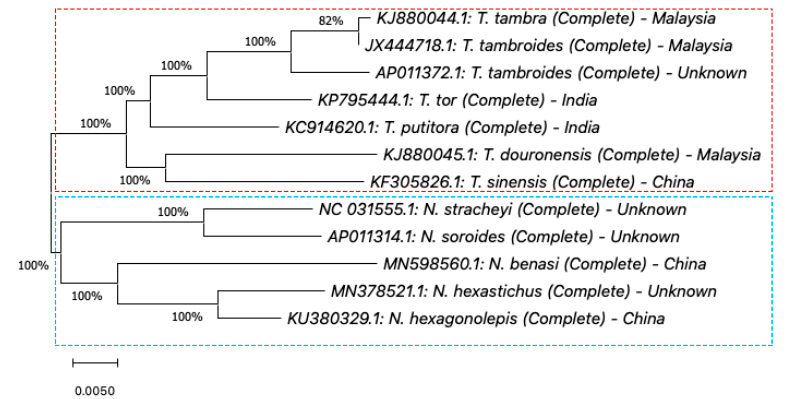
Figure 3. Phylogenetic tree of Tor species using seven complete sequences of the COX1 gene. The evolutionary history of the listed Tor species was inferred using the maximum likelihood method and Tamura–Nei model [126] . These analyses were conducted using MEGA X (Version 10.1) [114,115] . Percentages on the branches represent bootstrap values.